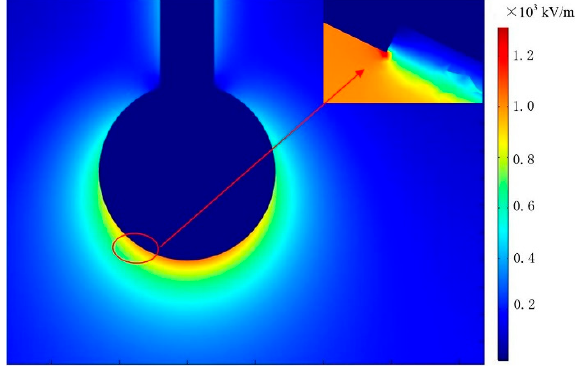
Figure 7. Shielding surface electric field distribution with 1-mm depth scratch. Table 4. Maximum surface electric field distribution with different depth of scratches on Φ 1.3 m.